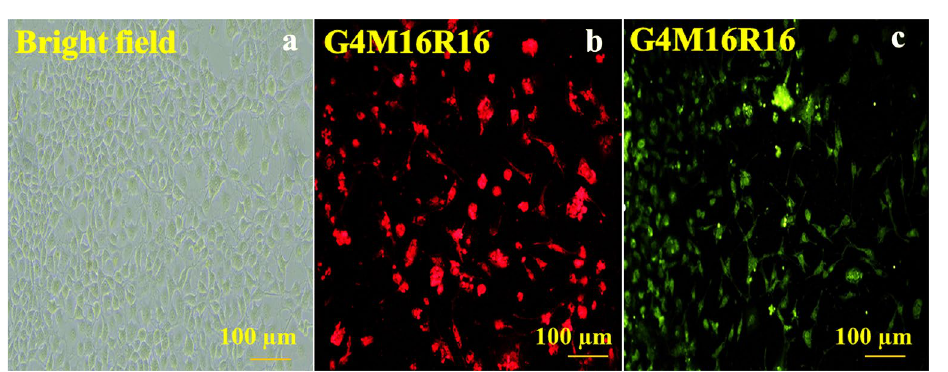
Figure 5. The fluorescence images of hybrid dendrimers-SH-SY5Y at